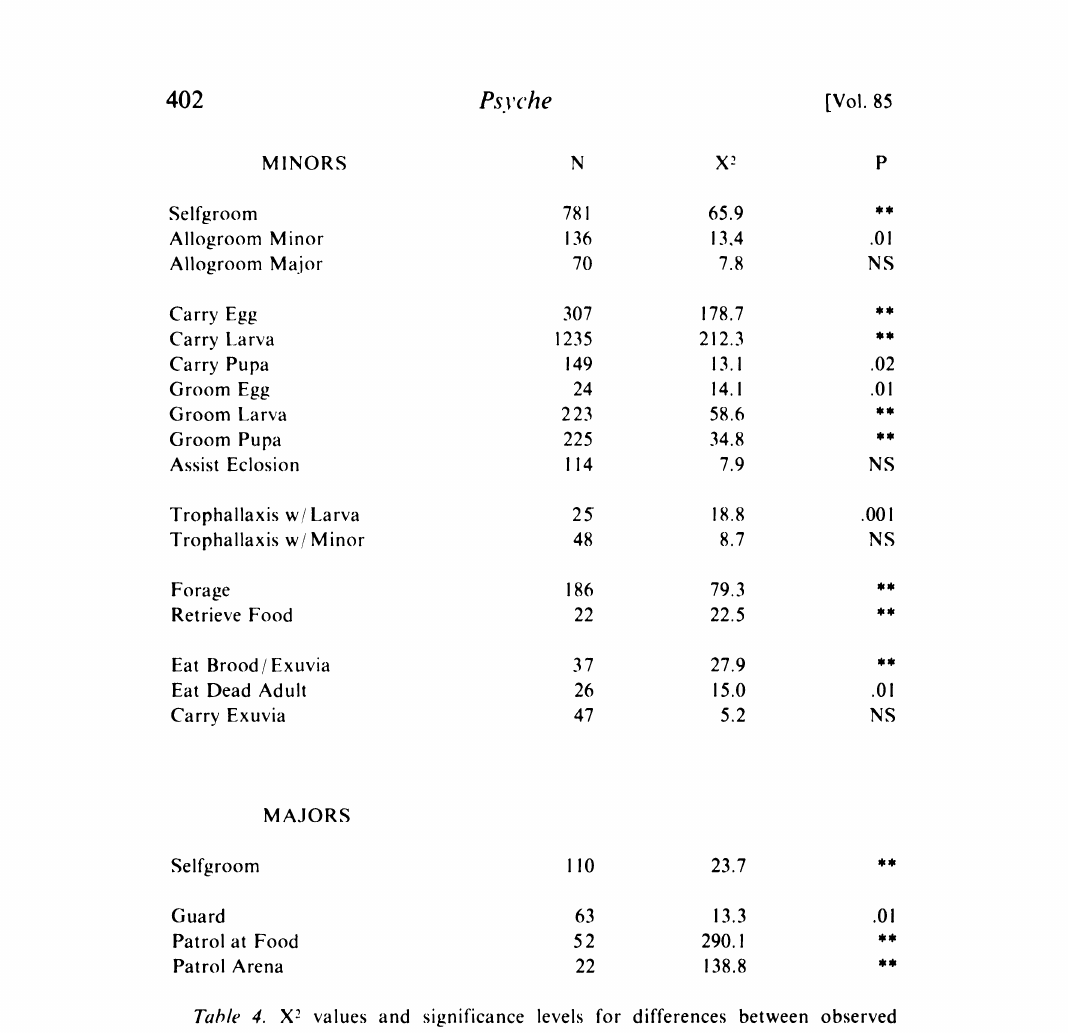
Table 4. X values and significance levels for differences between observed and expected behavior frequencies for the five age classes within each physical caste. ** indicates that the P values were so small they do not appear in the X-’ table and are highly significant. NS. no significant difference. Only behaviors with frequencies > oA are included. N total number of acts